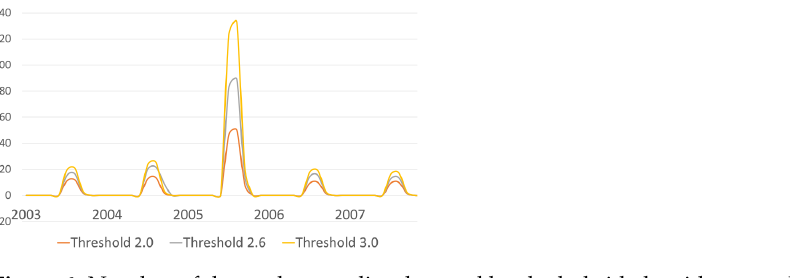
Figure 6. Number of thermal anomalies detected by the hybrid algorithm over MODVOLC using thresholds of 2.0, 2.6, and 3.0,